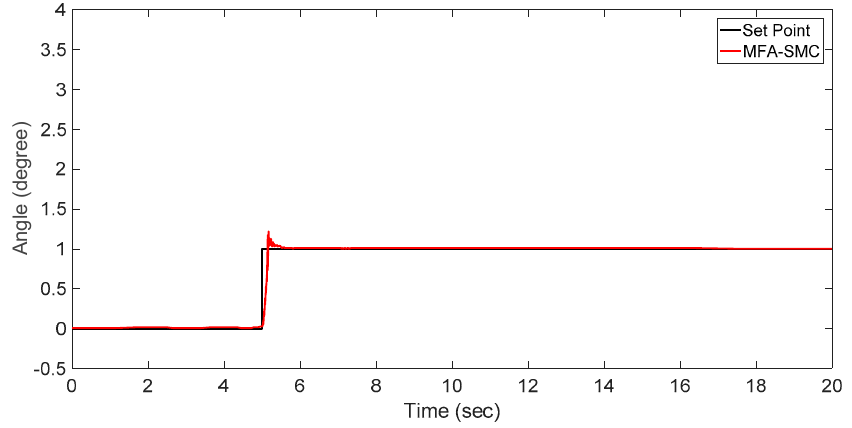
Figure 16. Step response of BLDC Motor using Model Free Adaptive and Sliding Mode Control.